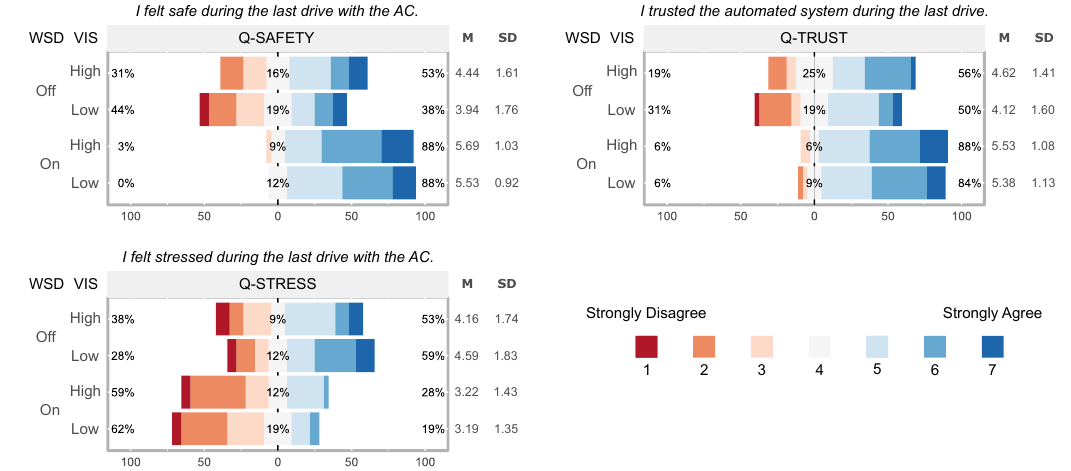
Figure 10. Subjective results from the inter-test questionnaire regarding feelings of safety, stress and trust under the different main conditions. Participants were encouraged to envision a comparable real-world experience of their last simulated lab drive before answering.